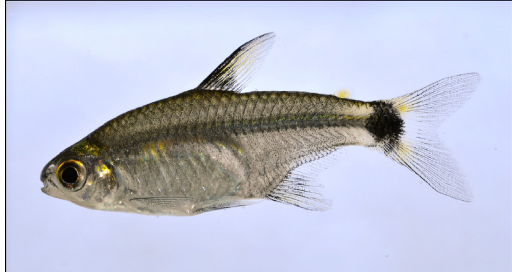
Figure 3. Photography of a live adult male of Serrapinnus notomelas (approximately 35 mm in total length), taken in an aquarium